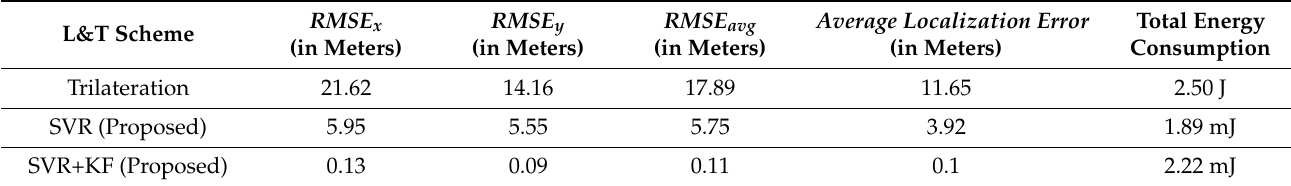
Table 4. Average localization error and RMSE for case